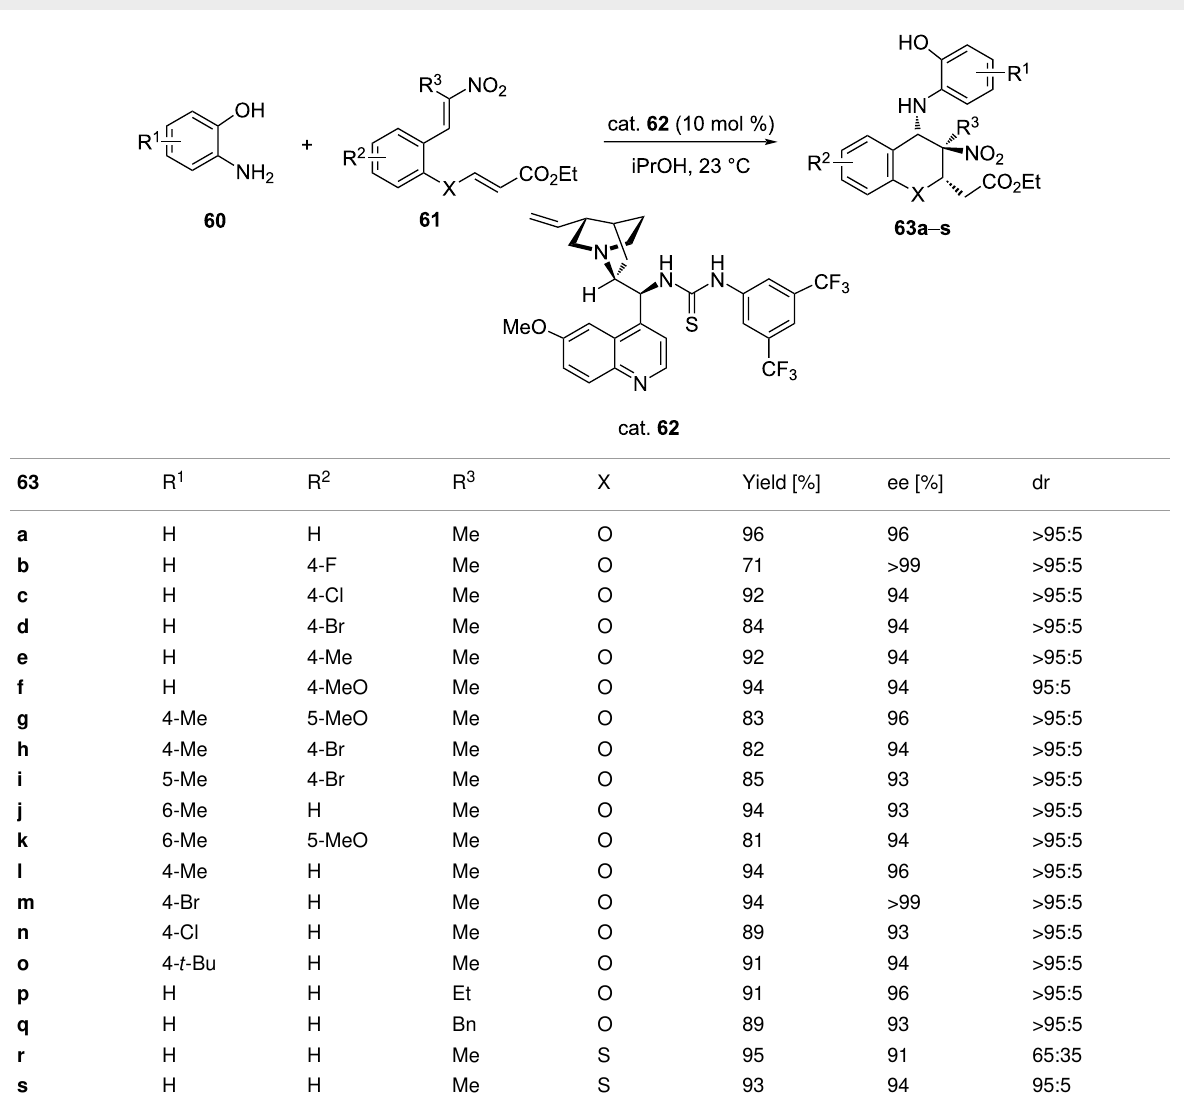
Table 14: Asymmetric aza-Michael addition reaction catalysed by chiral bifunctional